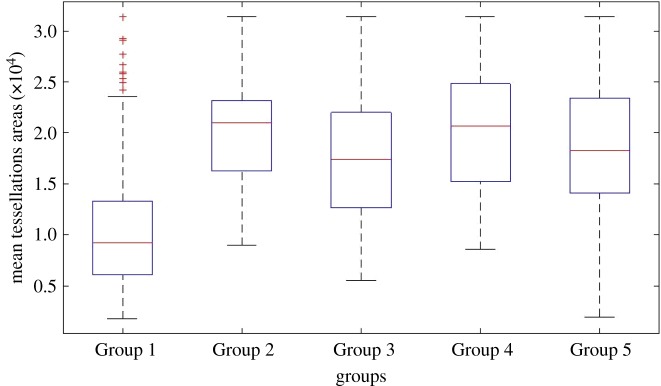
Box and whisker plots show the distribution of tessellation areas for the different groups gathered over 10 time-points. Red lines indicate the medians, boxes cover the 25th and 75th percentile and whiskers extend to 1.5 times the inter-quartile range. Red plus symbols indicate outliers. The mean tessellation areas for each group across all time points were, Group 1: M = 10383.29, s.d. = 5503.682; Group 2: M = 20218.67, s.d. = 5626.12; Group 3: M = 17732.70, s.d. = 6493.58; Group 4: M = 20506.39, s.d. = 6404.64, Group 5: M = 18298.48, s.d. = 7006.30.